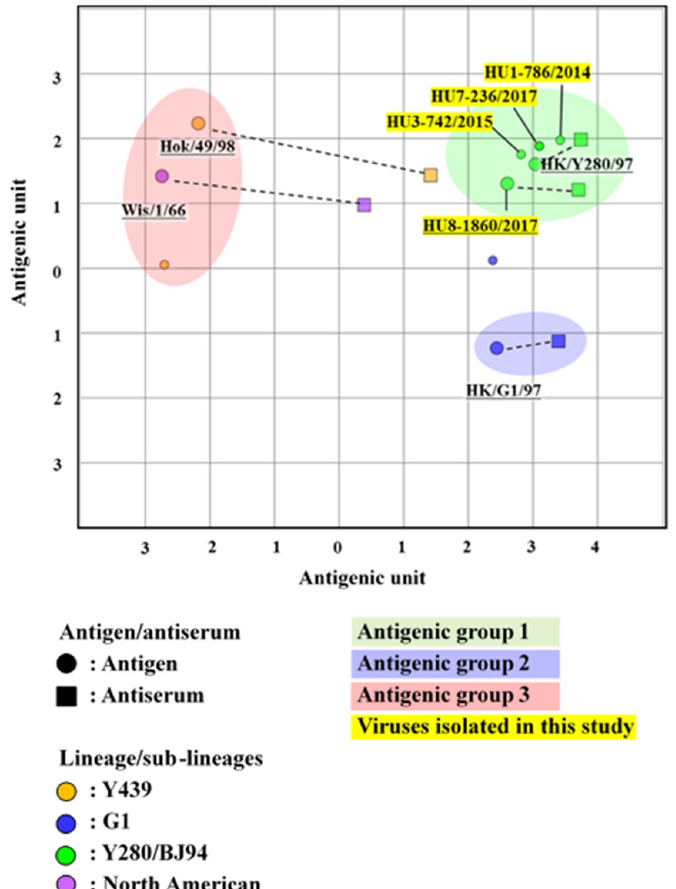
Figure 4. An antigenic map of H9 viruses based on the cross-HI tests on viruses and sera of different lineages. In the antigenic map, both the vertical and horizontal axes represent the antigenic distance. The spacing between the grid lines represents a 1 antigenic-unit distance, corresponding to a 2-fold dilution in the HI assay (2 units correspond to a 4-fold dilution, 3 units correspond to an 8-fold dilution, etc.). Different antigenic groups are indicated by different colors (green, blue, and red). Dotted lines indicate a combination of the homologous viruses and antisera.